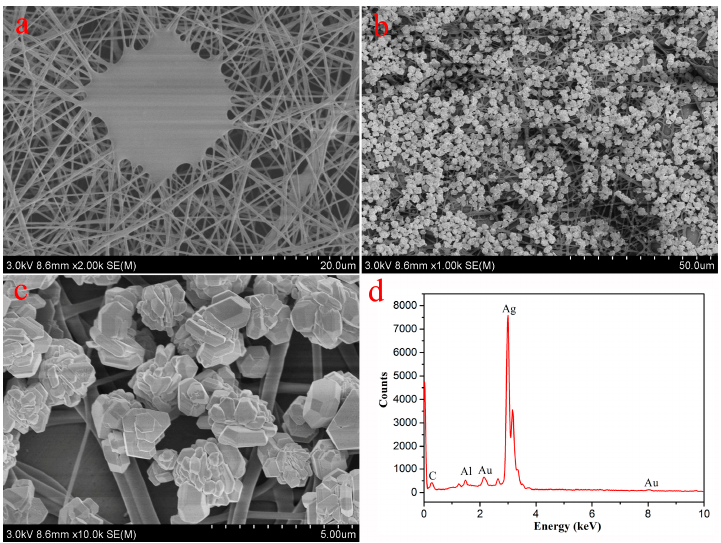
Figure 2. SEM images of the prepared PVA/PAA/GO-COOH nanocomposite by electrospinning